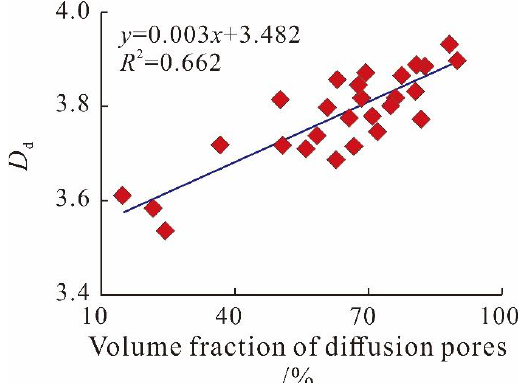
Figure 7. Relationship between volume fraction of diffusion pores and diffusion fractal dimension ( D d ).